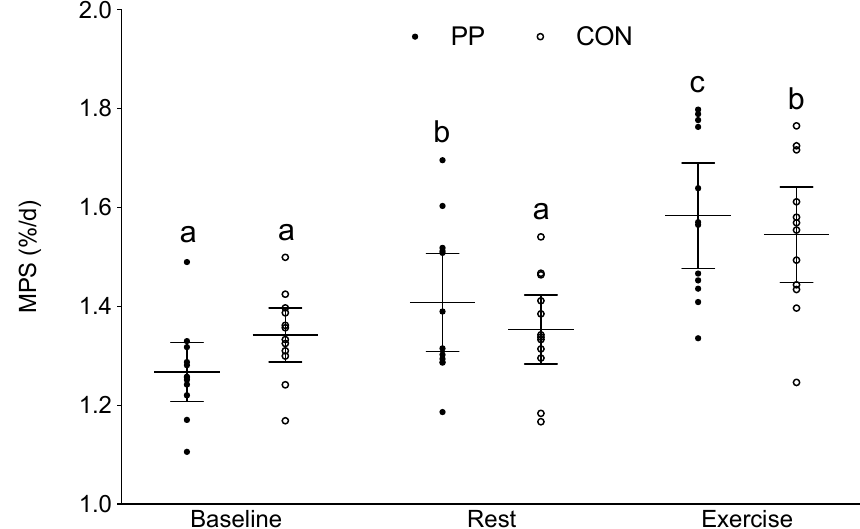
Figure 2. Integrated myofibrillar protein synthesis (% / day) at Baseline, and at Rest and with Exercise during the supplementation period. The horizontal line represents the mean, and the whiskers represent the 95% confidence interval. Means that do not share a letter are significantly different within the same group, p = 0.008. FSR, fractional synthetic rate; PP, potato protein supplemented group; and CON, control diet group.